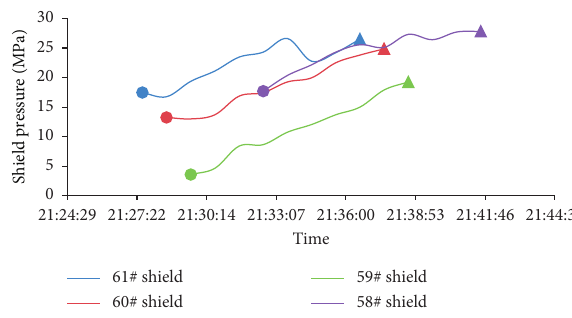
Figure 9: Four neighboring supporting loads variation after the initial setting in the same